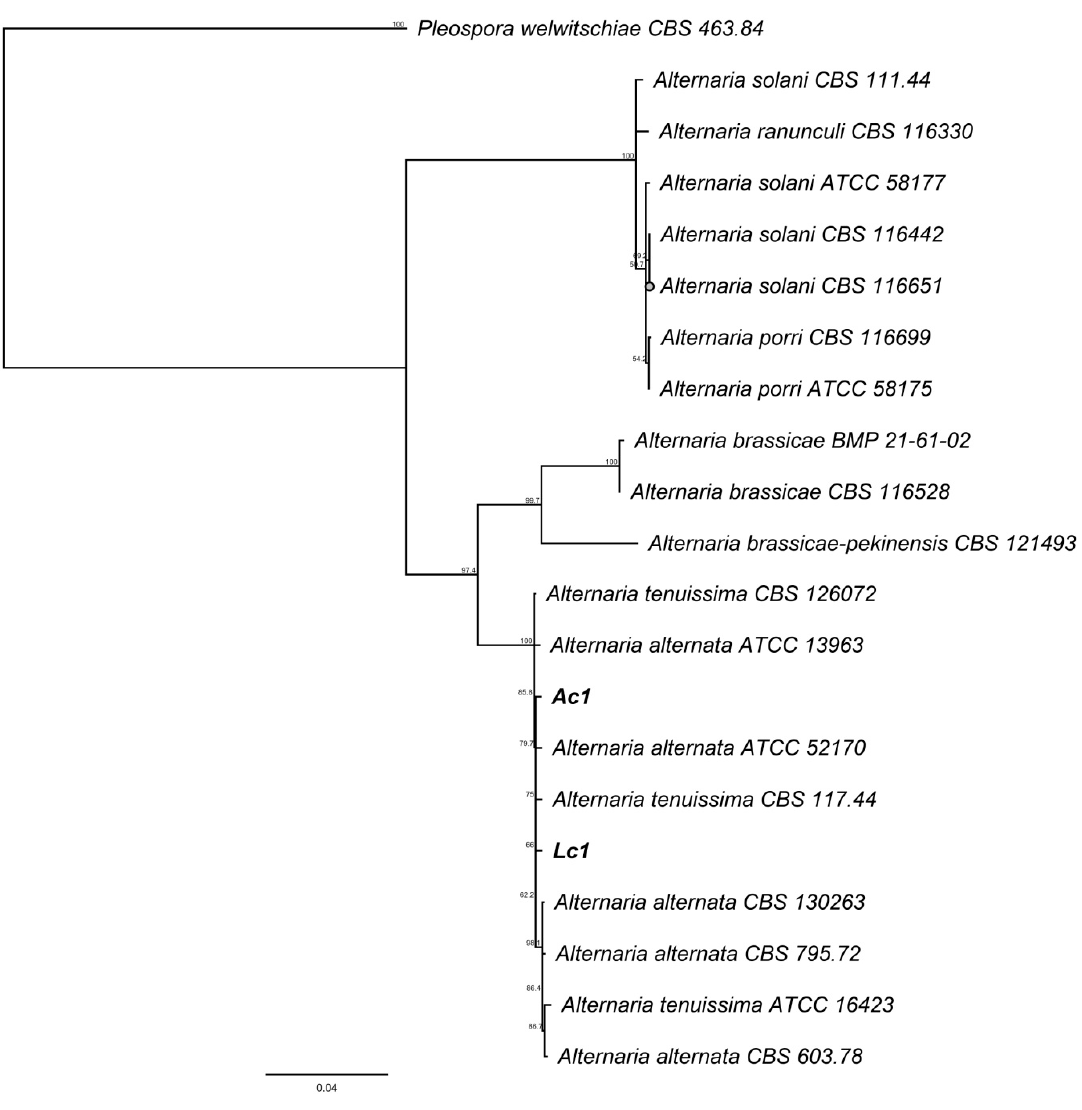
Figure 5. Neighbor-joining tree based on fungal internal transcribed spacer (ITS) sequences of Ac1, Lc1, 15 Alternaria spp. and Pleospora welwitschiae as outgroup. Numbers labeled at each node indicate bootstrap value (%) from 1000 replicated.